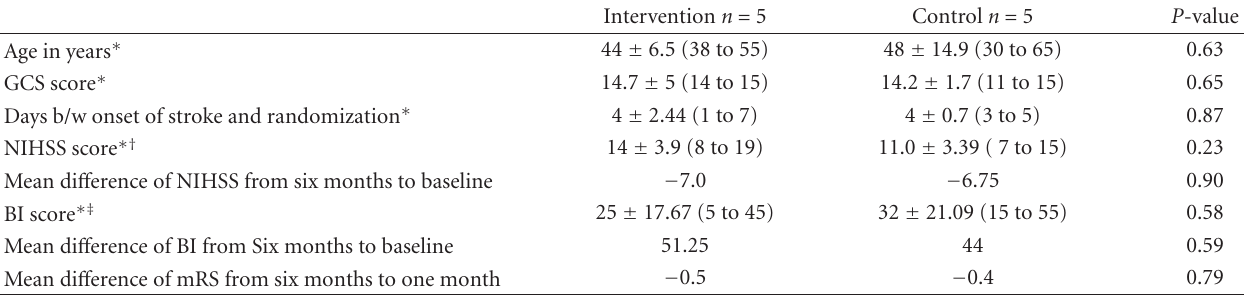
Table 3: Summary of patient characteristics and e ffi cacy outcomes (di ff erence between six-month and baseline scores).